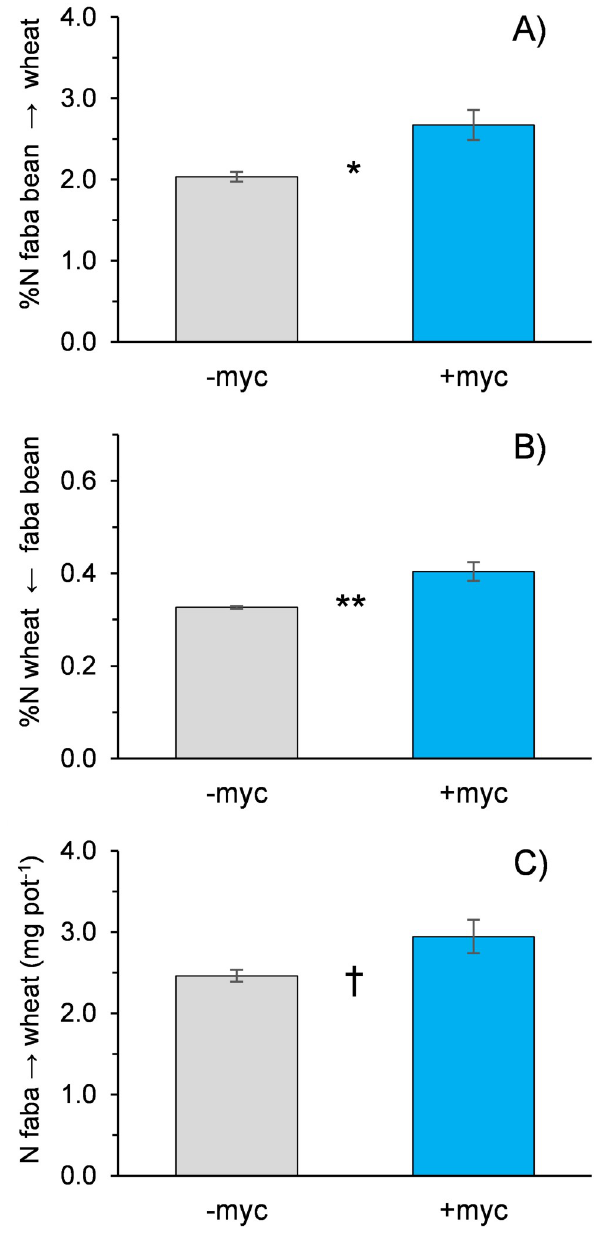
Fig 4. Percentage of N transferred from faba bean to wheat (A), percentage of wheat N derived from faba bean (B), and amount of N transferred from faba bean to wheat (C) in the absence (–myc) or presence (+myc) of arbuscular mycorrhizal fungi. †, � , and �� indicate significant differences at P � 0.10, 0.05, and 0.01, respectively. Vertical bars indicate standard errors of each mean value (n = 5).